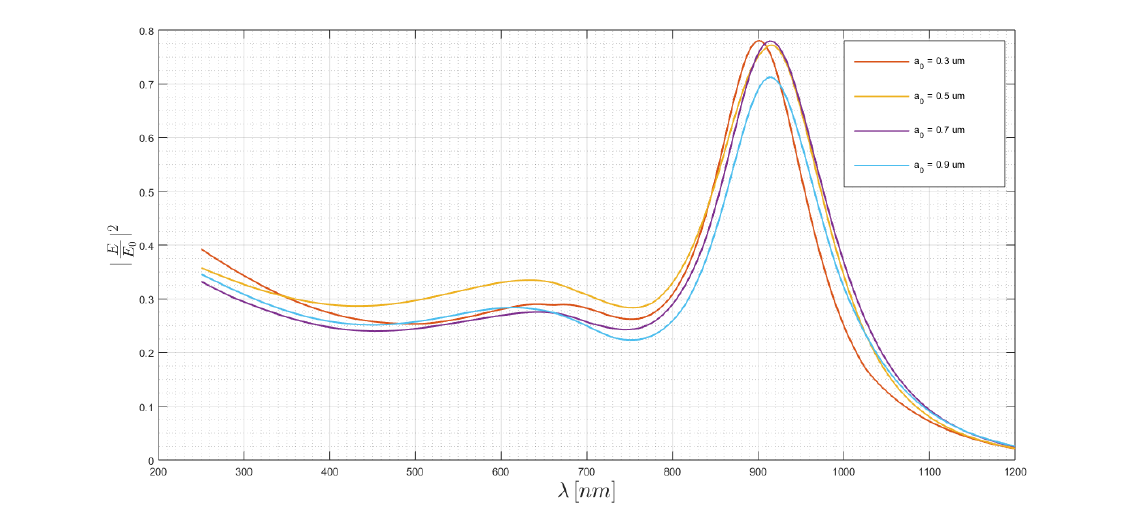
Figure 5. Periodicity sweep on the copper nanostructure.